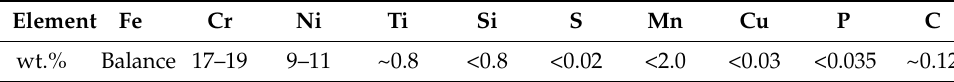
Table 3. Chemical content of X10CrNiTi18-10 (12kH18N10T) steel. Element Fe